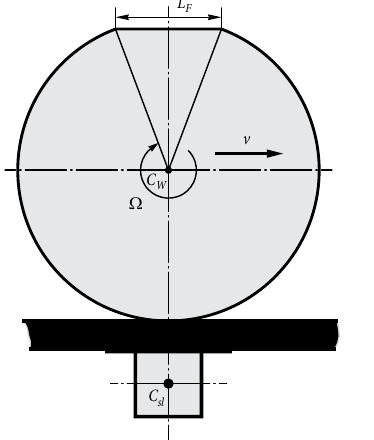
Fig. 6. The initial position of the wheel